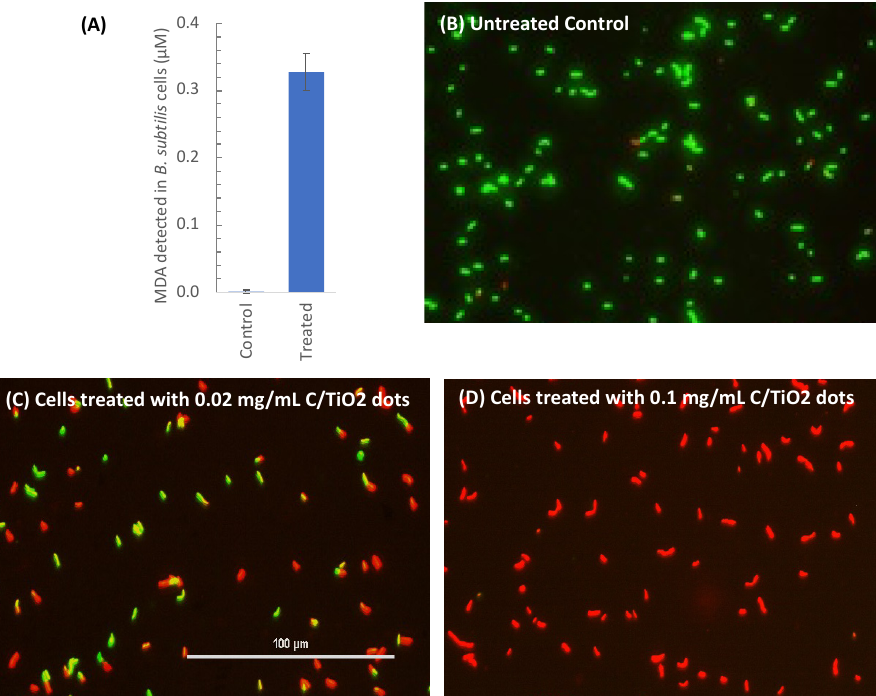
the disruption of cell membranes [41,42]. Often accompanying cell membrane damage is the lipid peroxidation [43], a multiple-step process in which lipid carbon-carbon double bonds are attacked by free radicals and/or strong oxidants [44–46]. Some studies have demonstrated that free radicals can induce cell membrane damage [47], and the oxidative stress can lead to lipid peroxidation, inhibiting bacterial growth [48]. Other studies have found that the membrane damage by photoexcited TiO 2 is often associated with lipid peroxidation [49]. The lipid peroxidation produces lipid hydroperoxides (LOOH) and various aldehydes including especially malondialdehyde (MDA) [50], which is commonly used as an indicator of lipid peroxidation. In this study, the extent of lipid peroxidation in B. subtilis cells upon the treatments of C/TiO 2 -Dots with visible light was measured by quantifying MDA with a commercial kit (TBARS Assay), which is based on the reaction of MDA with thiobarbituric acid (TBA) to form a red fluorescent adduct [51,52]. Shown in Figure 5A is the increased amount of MDA measured in Bacillus cells after the treatment with 0.1 mg/mL PEI&PEG-C/TiO 2 -Dots and visible light for 2 h. The amount is signifi- cantly higher than that in the untreated control samples, indicating the cell membrane lipid peroxidation caused by the highly reactive species produced in the treatment.